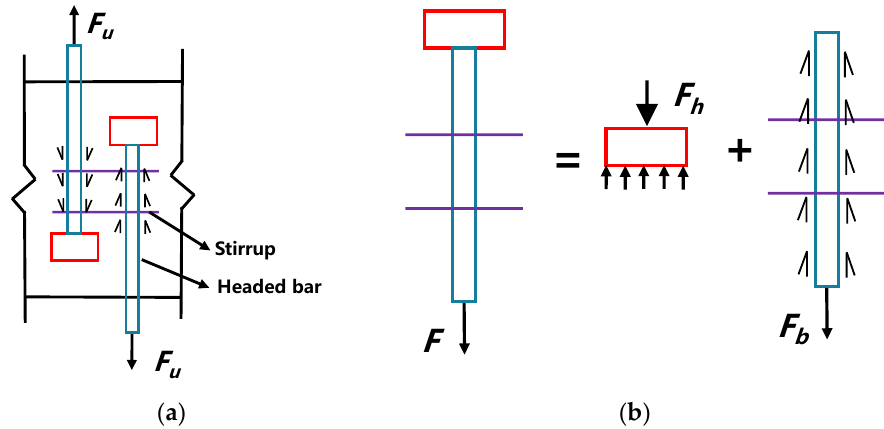
Figure 37. Capacity of CHBC ( a ) Sketch of the CHBC; ( b ) Head bearing and bond behavior. To determine the F h,u , the STM model as shown in Figure 38 is